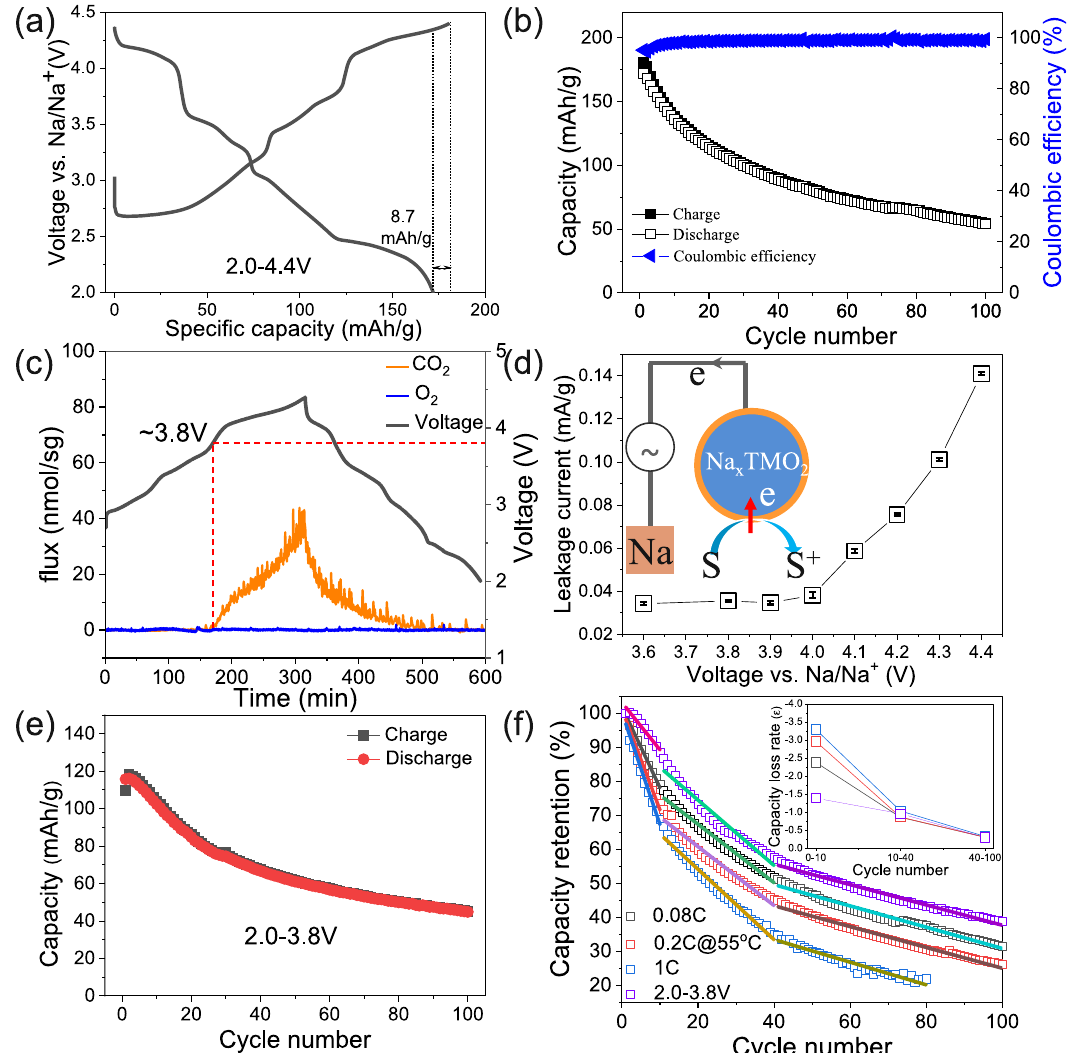
Fig. 2 Electrochemical characterization. a 1st charge/discharge curve and b cycling performance of strained O3 NaNi 0.4 Mn 0.4 Co 0.2 O 2 cathode within 2.0 – 4.4 V at 0.08C. c In situ DEMS and d parasitic reaction study of O3 NaNi 0.4 Mn 0.4 Co 0.2 O 2 cathode. S and S + in d represent solvents and oxidized solvents, respectively. e Cycling performance of strained O3 NaNi 0.4 Mn 0.4 Co 0.2 O 2 cathode within 2.0 – 3.8 V at 0.08C. f Normalized capacity retention of O3 NaNi 0.4 Mn 0.4 Co 0.2 O 2 cathode at different cycling conditions. The capacity loss rate in f is the slope of the linear fi tting curve of the capacity retention